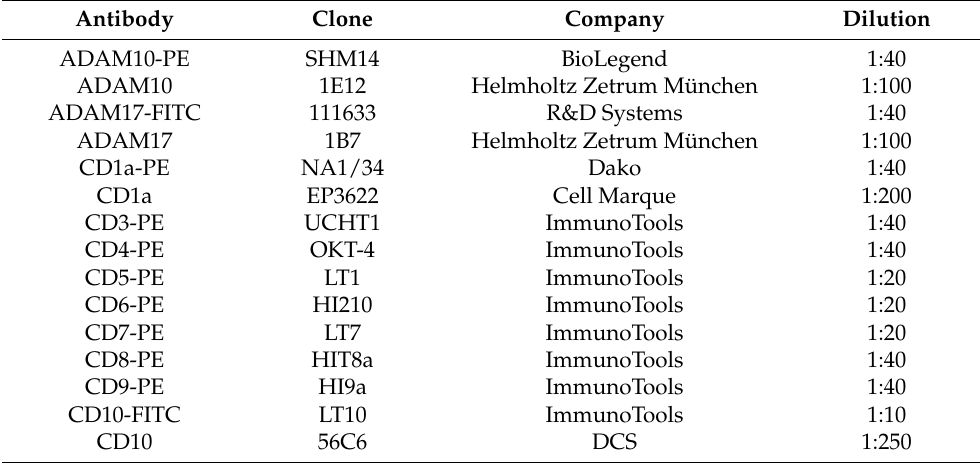
Table 1. Antibodies used for MAA and